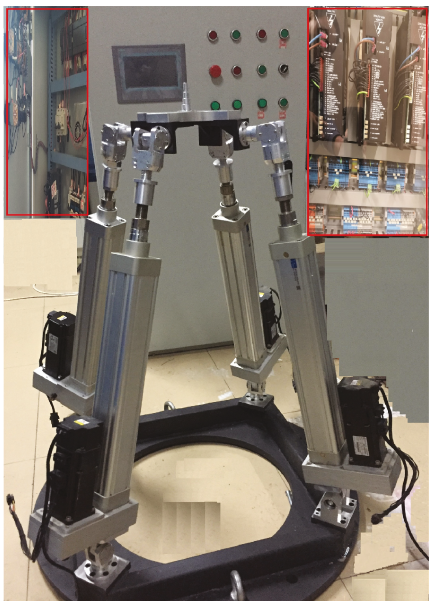
Figure 8: The experimental prototype of the parallel manipulator.